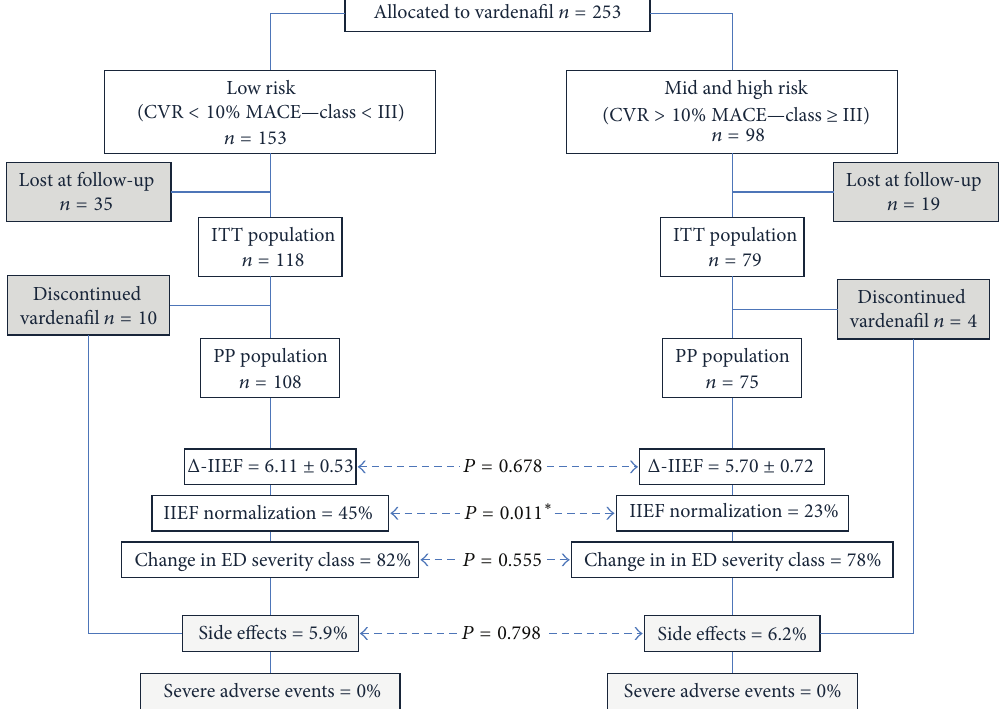
Figure 8: Comparisons of efficacy and safety for vardenafil treatment in subject with low versus high cardiovascular